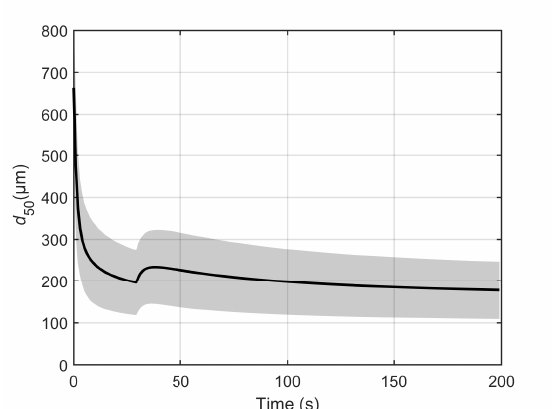
Figure 4. Model prediction (black solid) with 95% confidence range (shaded) using the Monte Carlo method with 12,000